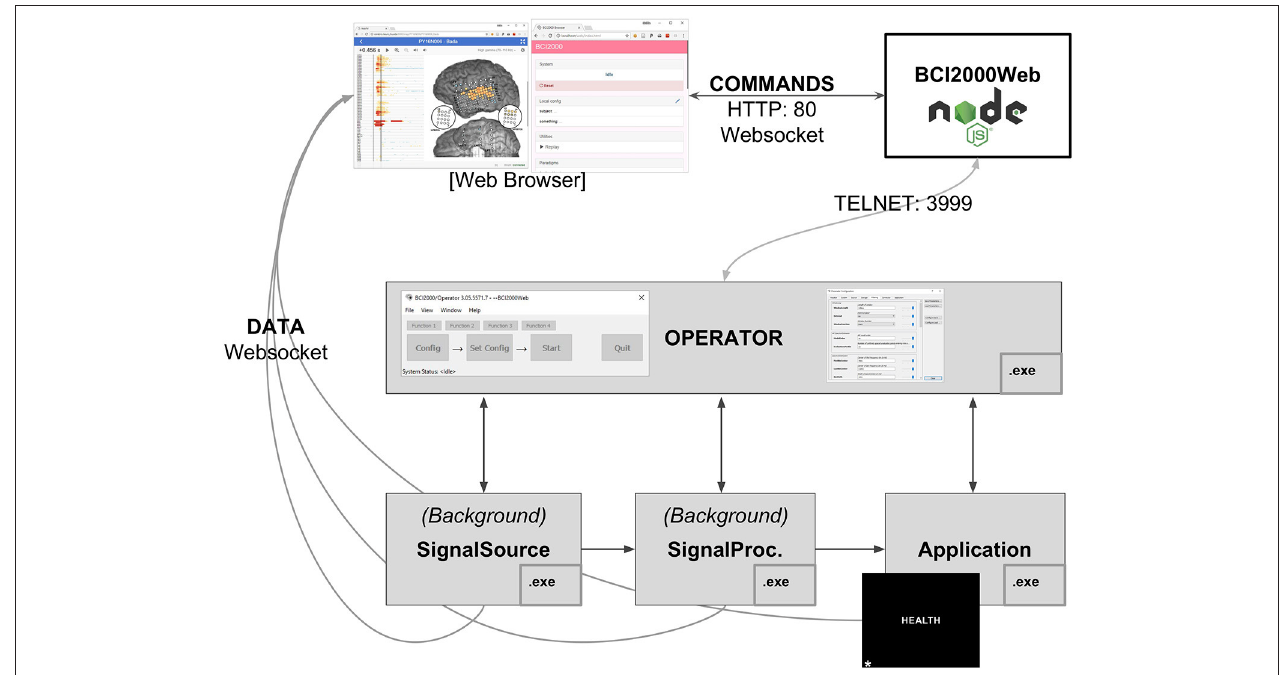
FIGURE 1 | A full BCI2000 stack including a Signal Source, Signal Processing, Application, and Operator module communicates with BCI2000Web, implemented as a Node.js module, via Telnet. Browser-based remote control software and visualization tools interact with BCI2000Web, and receive raw and processed neural signals directly from the BCI2000 system modules, via WebSockets, while the application module presents stimuli to the patient, in this case, the word stimulus “HEALTH” for a word reading